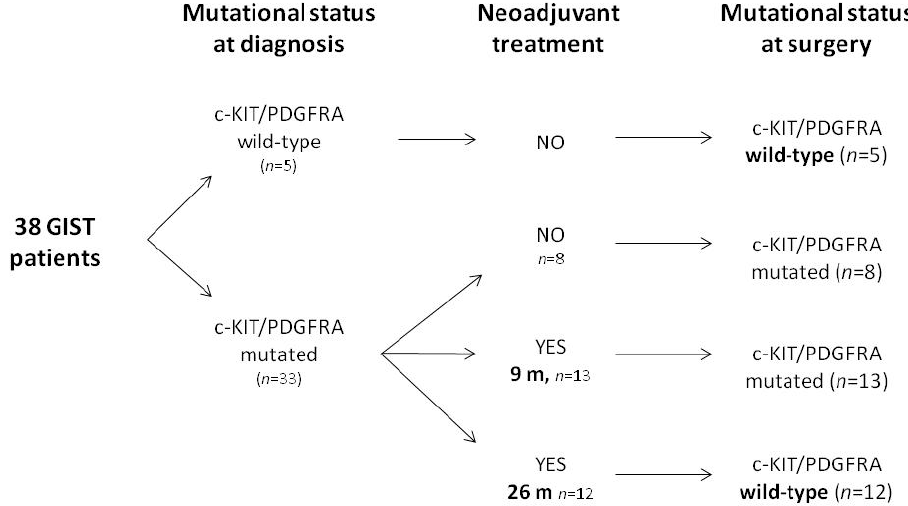
Figure 1. Schematic summary of the experimental platform from GIST patients. m = months.